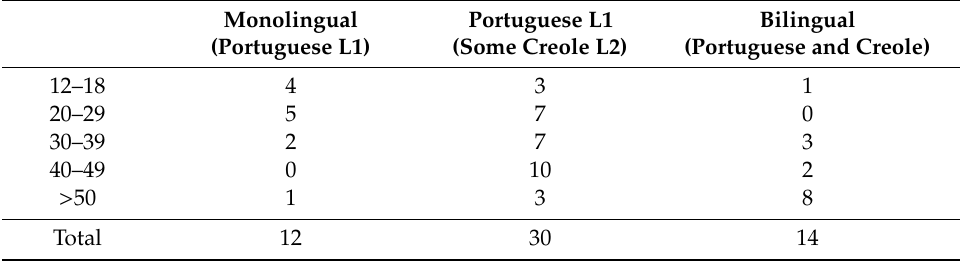
Table 3. Cross-tabulation between age and spoken languages (number of participants).